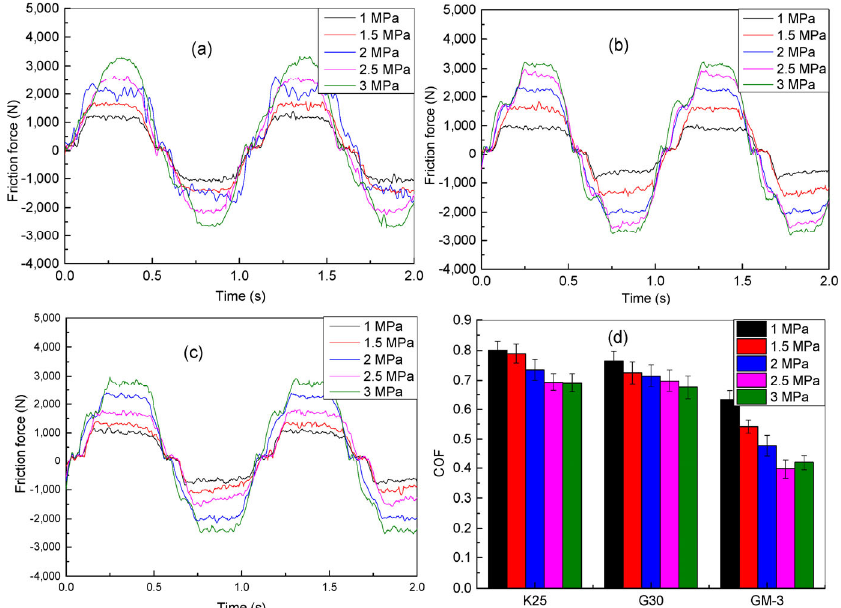
Fig. 12 Friction force and average COF of the friction lining under different pressures: (a) K25 lining, (b) G30 lining, (c) GM-3 lining, and (d) average